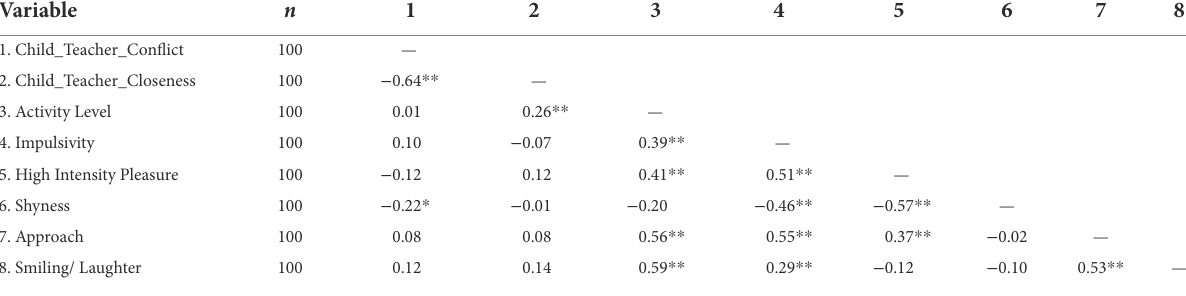
TABLE 4 Correlations for study variables (surgency).